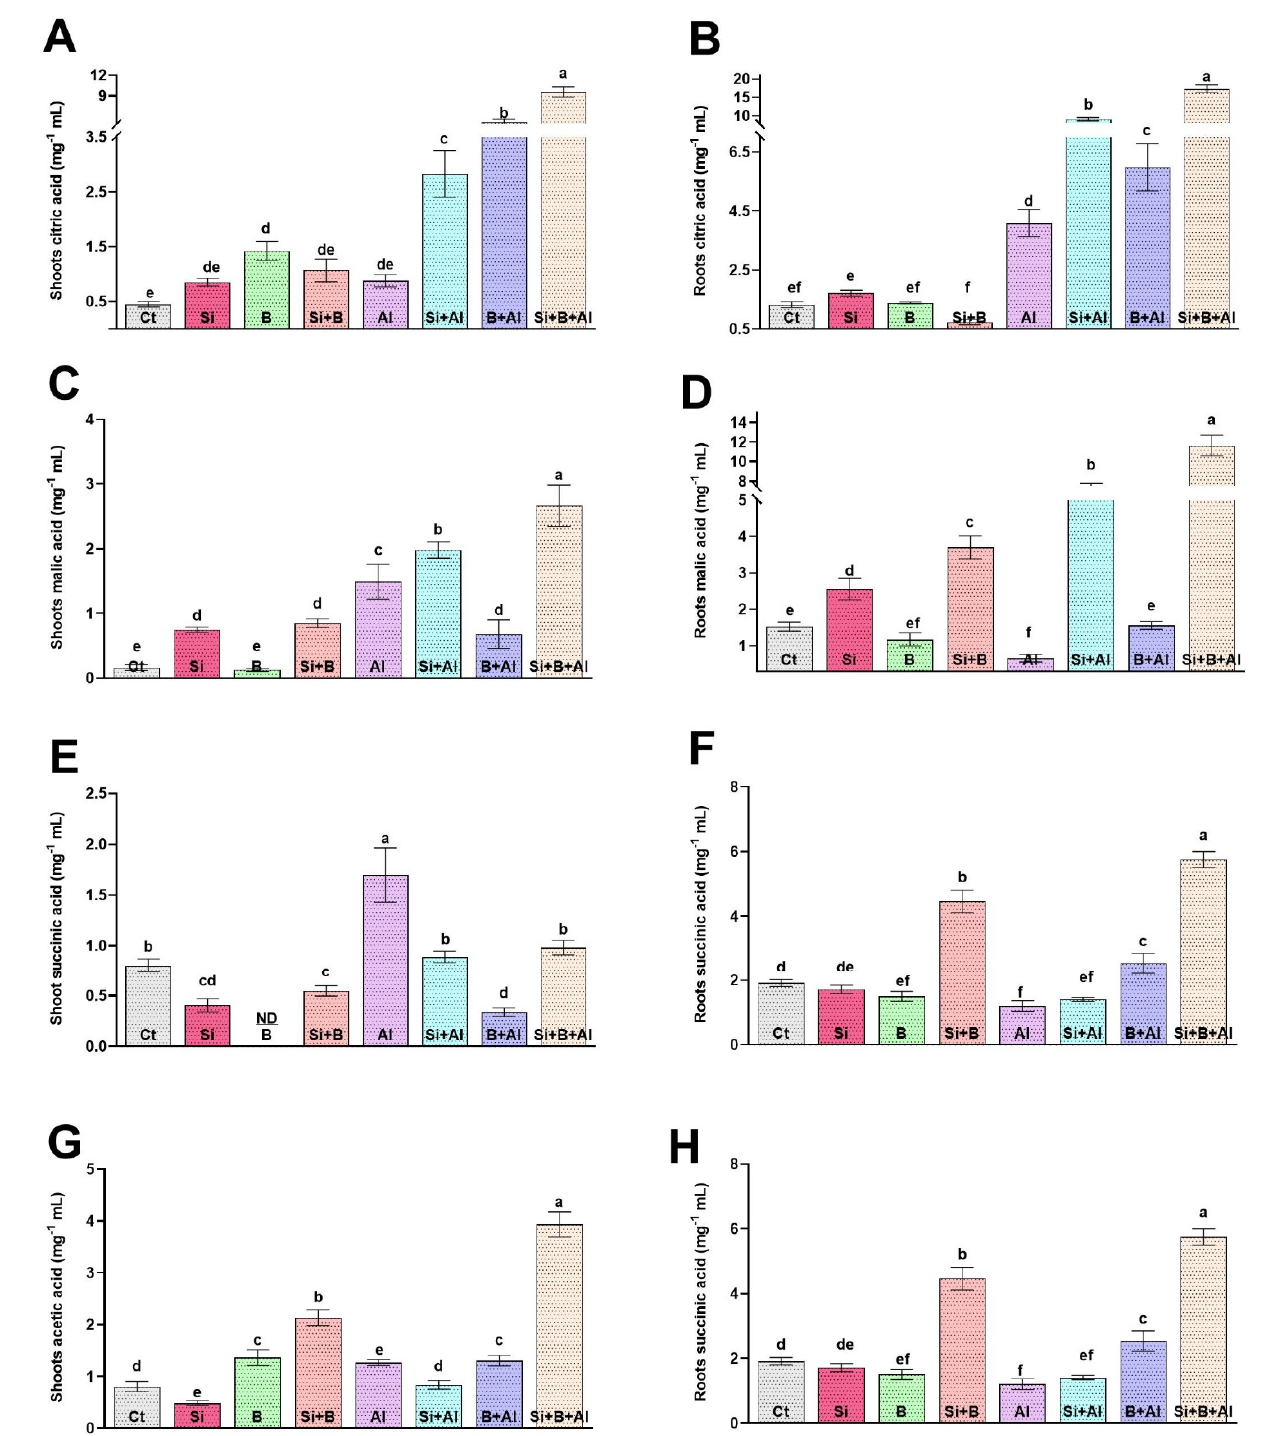
Figure 5. The sole and in-combination effect of Si and B on the organic acid regulation of date palm shoots and roots under Al-induced stress. ( A , B ) Citric acid, ( C , D ) Malic acid, ( E , F ) Succinic acid, ( G , H ) APX Bars with different letters are describing statistically significant differences ( p < 0.05) between means by using one-way analysis of variance (ANOVA), followed by Duncan’s multiple range test (DMRT). The bars describe the mean (of four replicates) ± standard error. On the contrary, the acetic acid level was significantly enhanced by the combined treatment of Si + B in both roots and shoots under control and stress conditions, compared